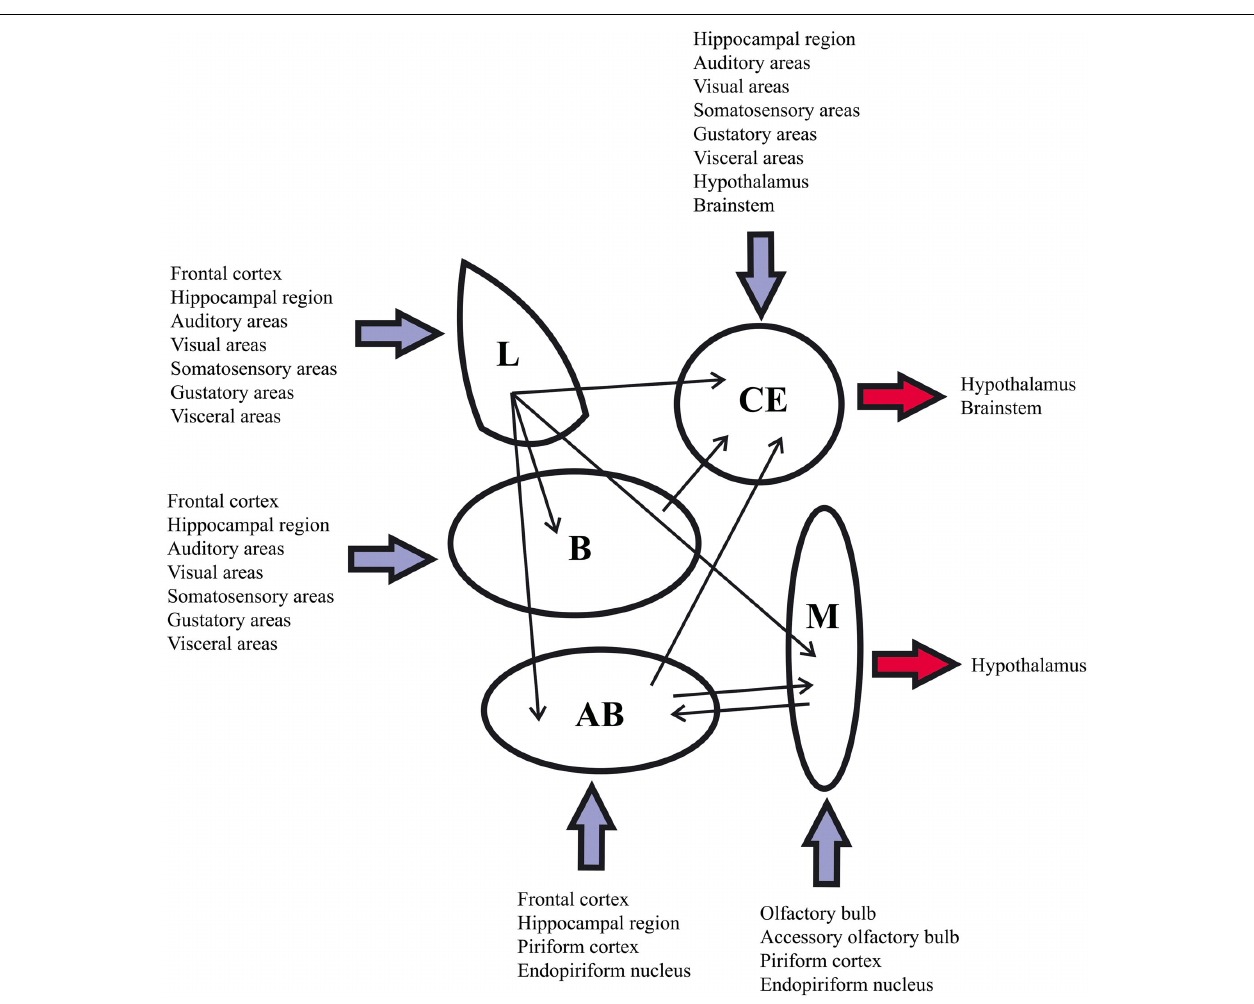
FIGURE 2 | Summary of the main extra-amygdaloid and intra-amygdaloid connections in the rat. For abbreviations see Table 1